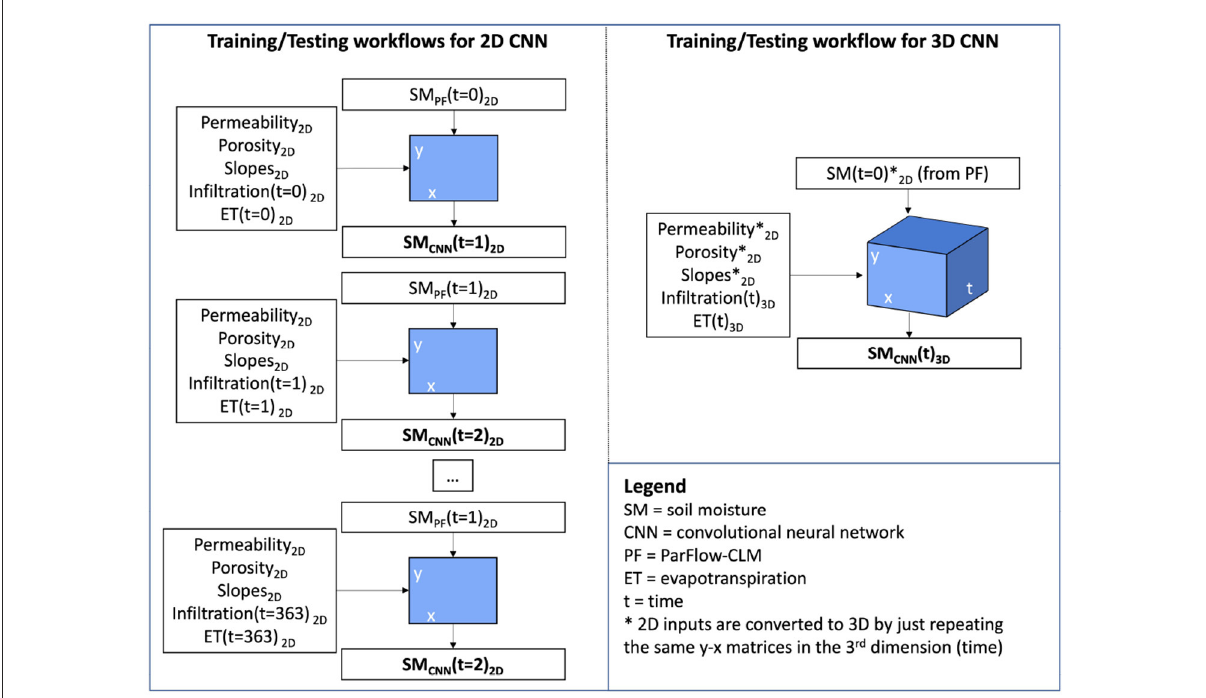
FIGURE2 Workflow for the training and testing of the 2D (left) and 3D (right) Convolutional Neural Network. For the 2D architecture at every timestep, the static and dynamic inputs as well as the soil moisture simulated by ParFlow-CLM are fed to the model, while the soil moisture of the next day is provided as the label (or predicted in testing mode). This operation is repeated on all days of the year. For the 3D architecture, the 3rd dimension is time, and all static inputs (including soil moisture at day 0) and dynamic ones are fed to the model, while the label is the 3D moisture field. 2D (static) inputs are repeated for the 3rd (time)